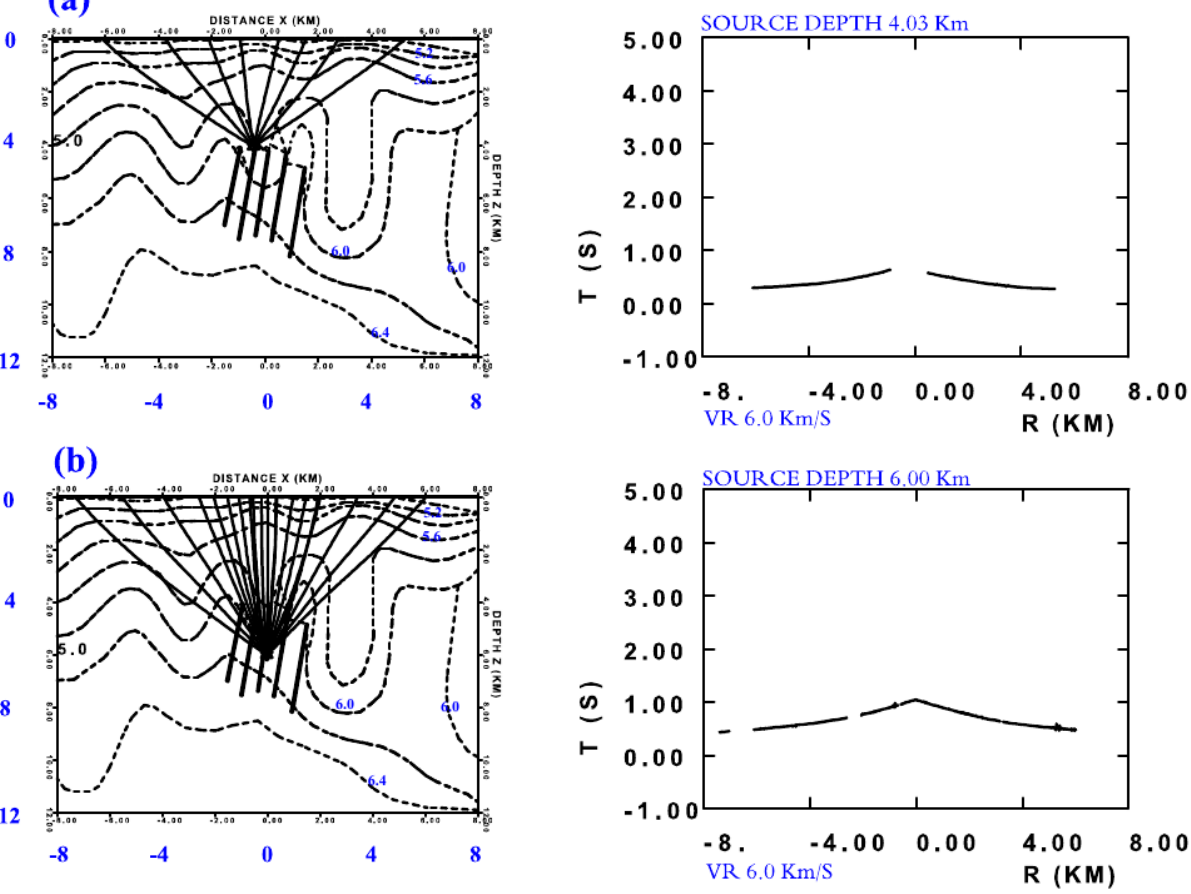
iso-velocity plots given by Dixit et al. [2014] for a limited region (as shown by a square near the seismograph station DH in Figure 13. V P Figure 1a) along with the ray paths obtained in the present study for two source depths at ~4 km and ~6 km and the resulting travel time curves for the direct P waves in the available offset range −8 to 8